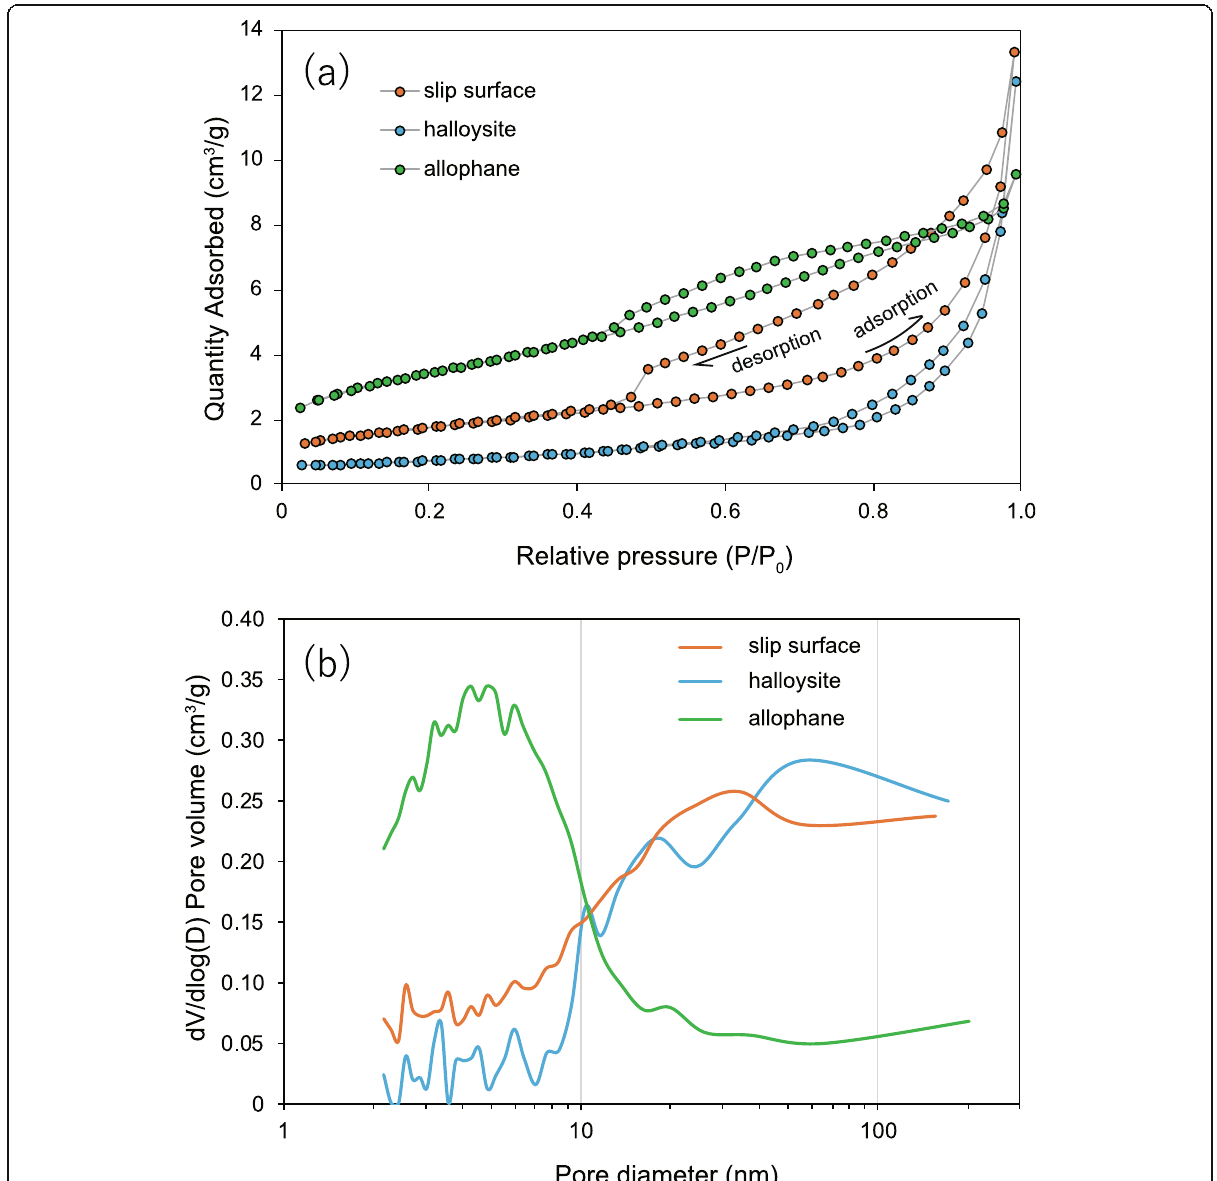
Fig. 5 Results of the N 2 adsorption – desorption experiments. (a) N 2 adsorption – desorption isotherms for the slip surface material, halloysite, and allophane. (b) Pore size distribution (PSD) curves obtained from BJH analysis